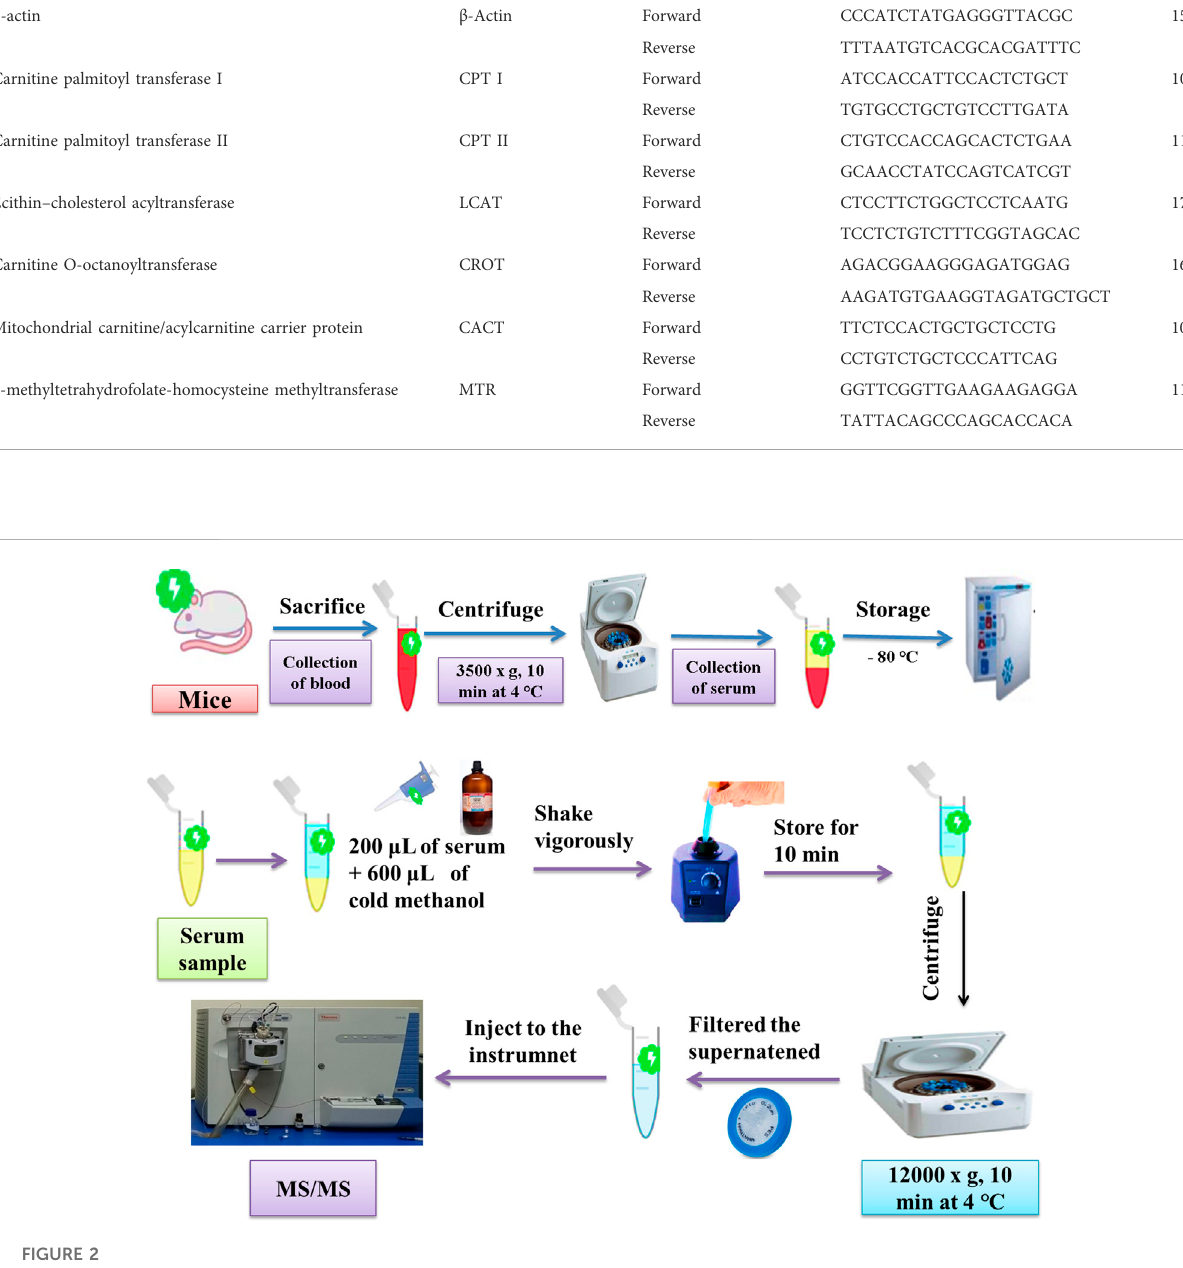
Frontiers in Molecular